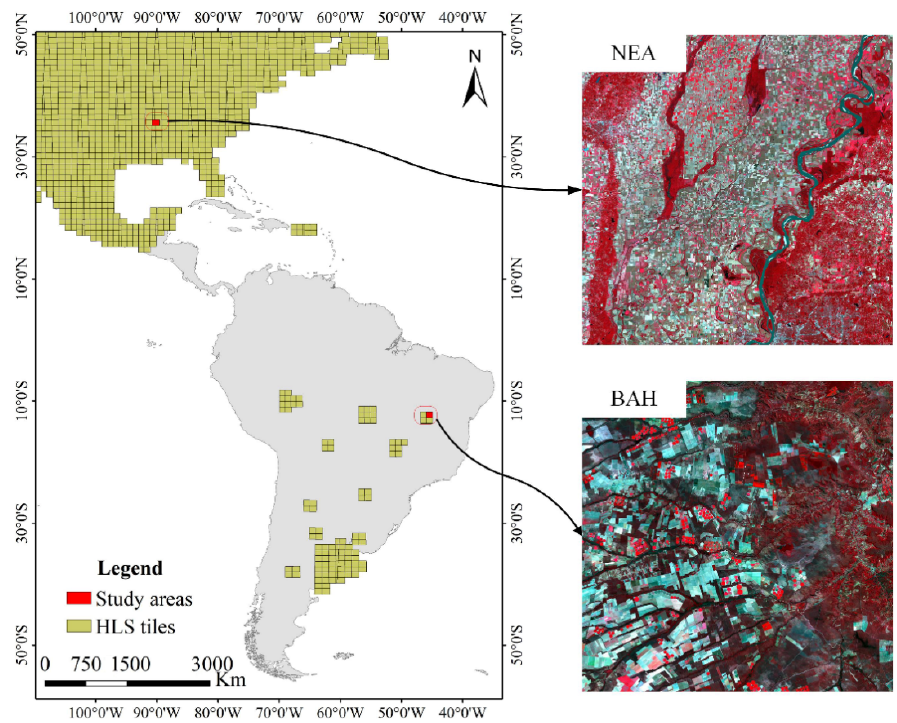
Figure 1. Standard false-color-composite images of NEA area and BAH area on 11 May 2016 and 28 September 2016,